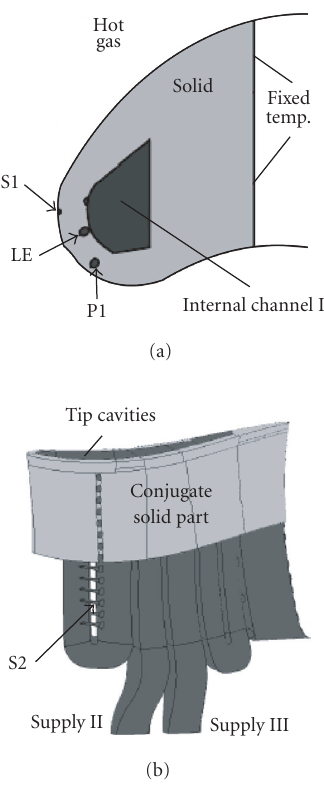
Figure 8: Numerical models of blade geometry. (a) Task 1: leading edge cooling model. (b) Task 2: model without leading edge cool- ing.